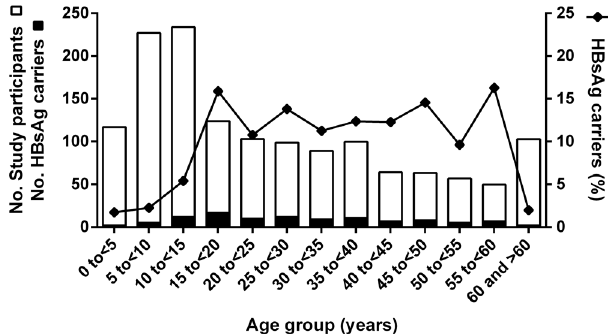
Fig 2. Age distribution and percentage of HBsAg carriers. A stacked graph of the total number of study participants for each age group (white bar) and of the corresponding number of HBsAg carriers (black bar) (left y-axis) is shown. The percentage of HBsAg carriers for each age group (right y-axis) is indicated by